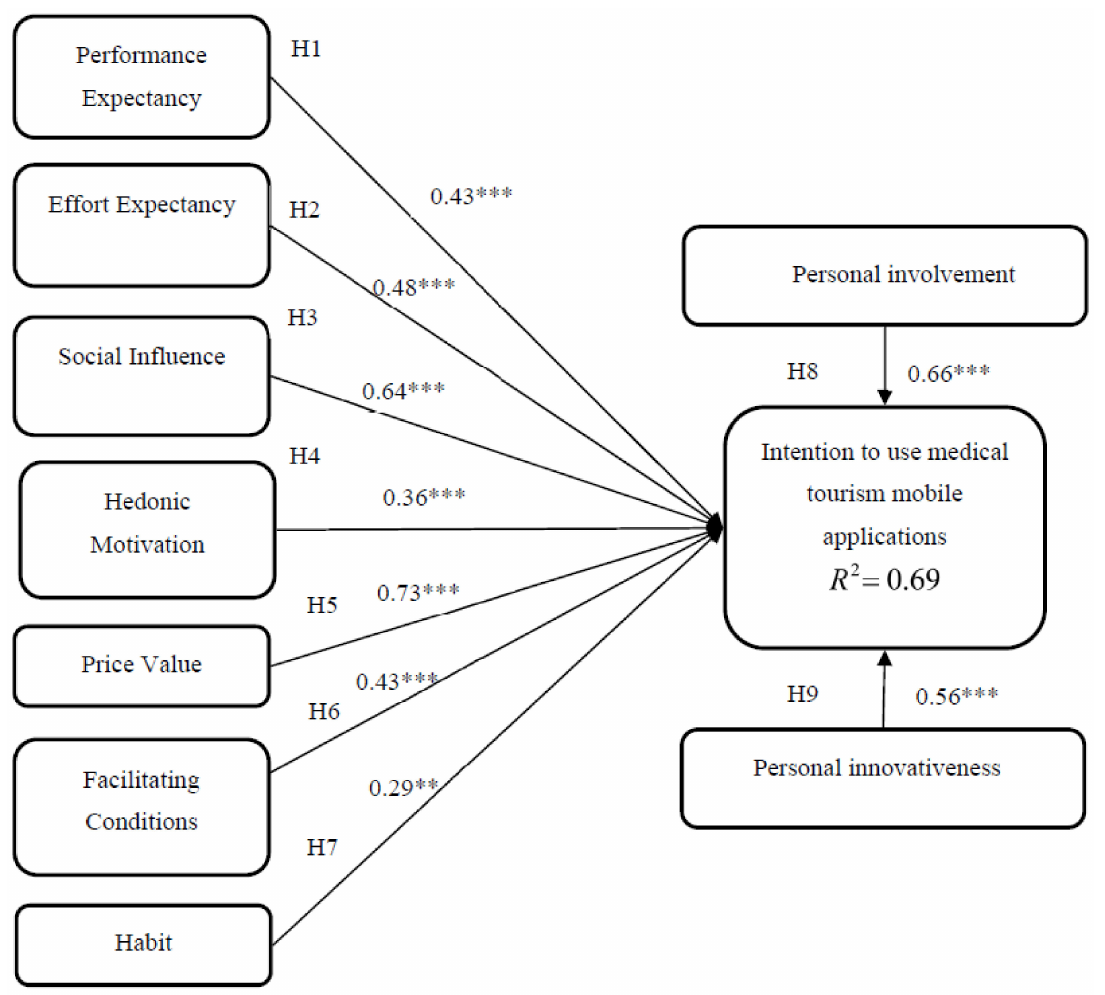
Figure 2. Results of testing model. ** p < 0.01; *** p <